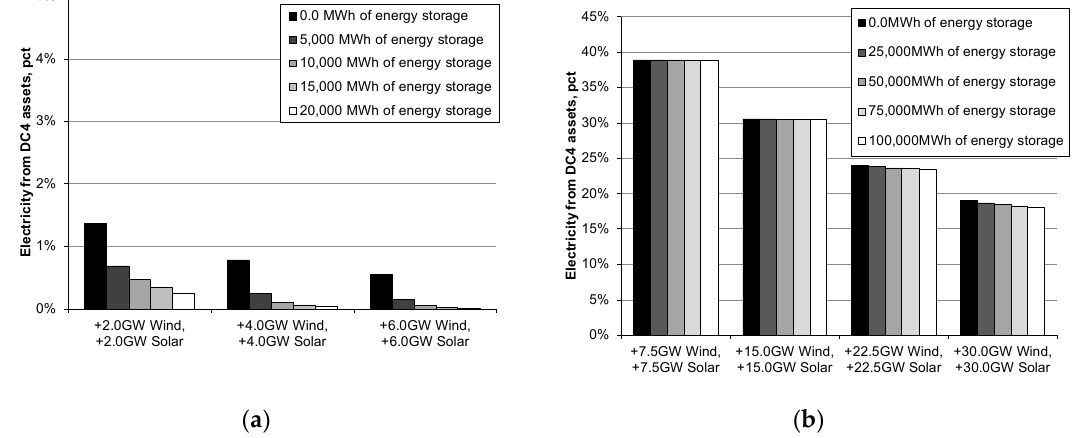
Figure 10. Annual percentage of electricity from DC4 assets under different energy storage scenarios in ( a ) New Zealand and ( b ) Great Britain.